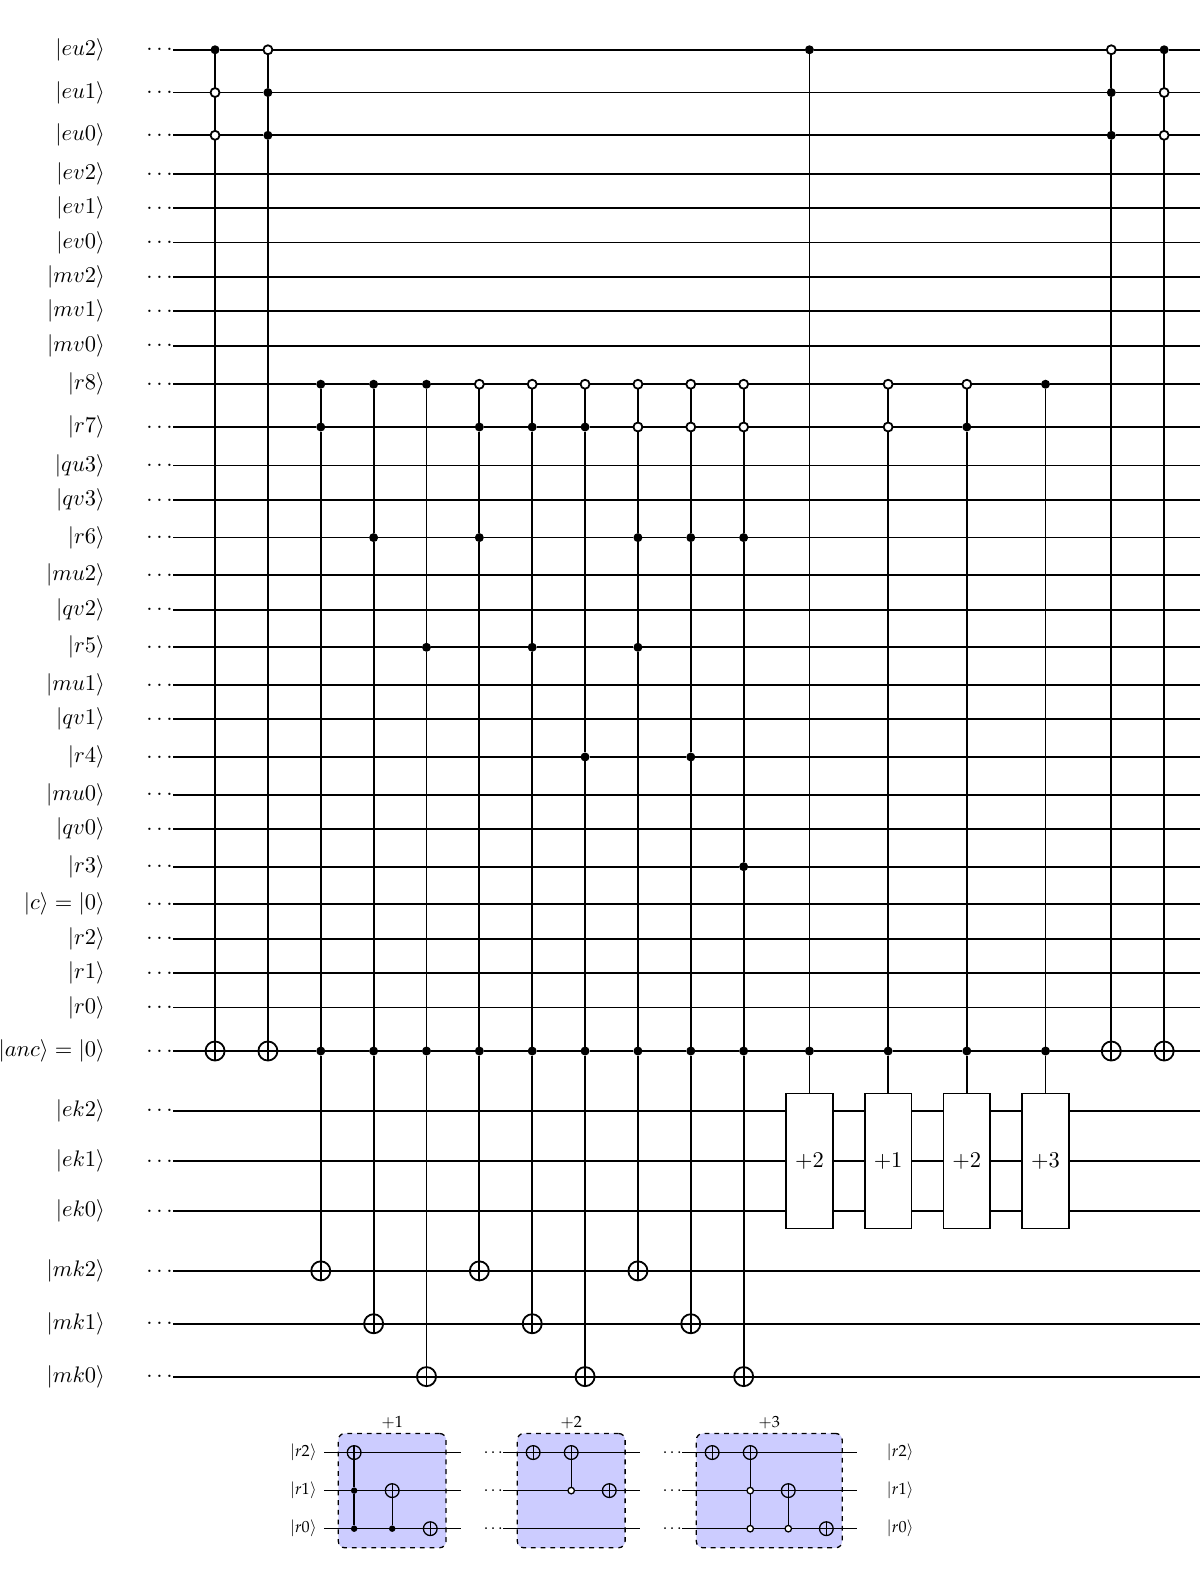
Figure 17. Quantum circuit implementation of CC used to set u 2 + v 2 in the floating-point format from the 9-qubit work register. N M = 4 and N E = 3. The exponent bias is five. Part